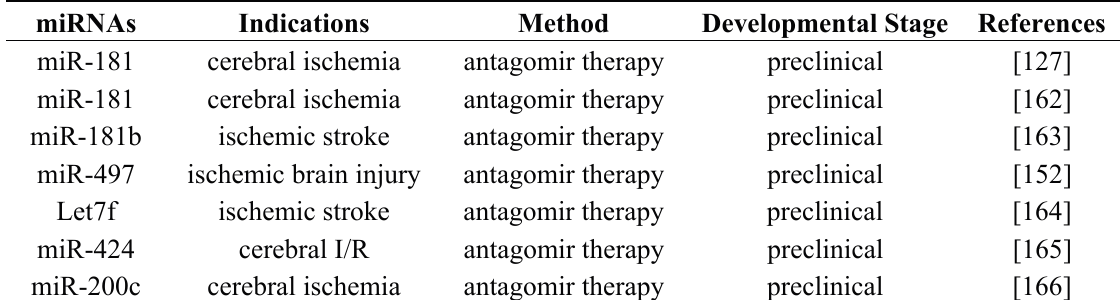
Table 2. miRNAs as therapeutic